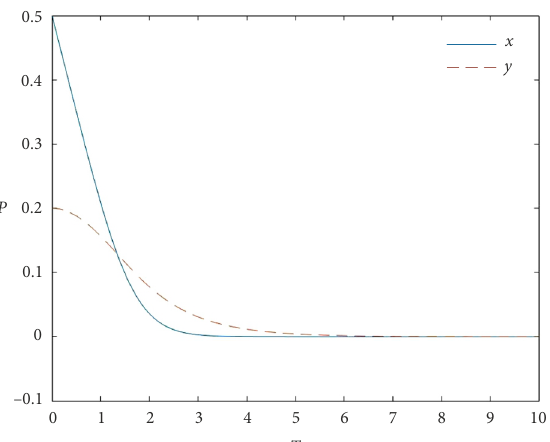
Figure 5. Probability trends for developers and